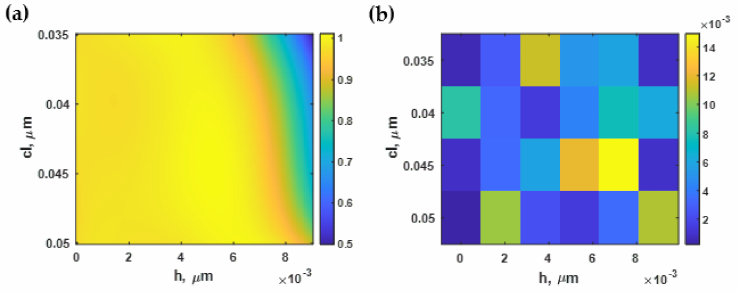
Figure 9. ( a ) The normalized sensitivity based on Equation (8); and ( b ) the difference between Equation (8) and the RCWA